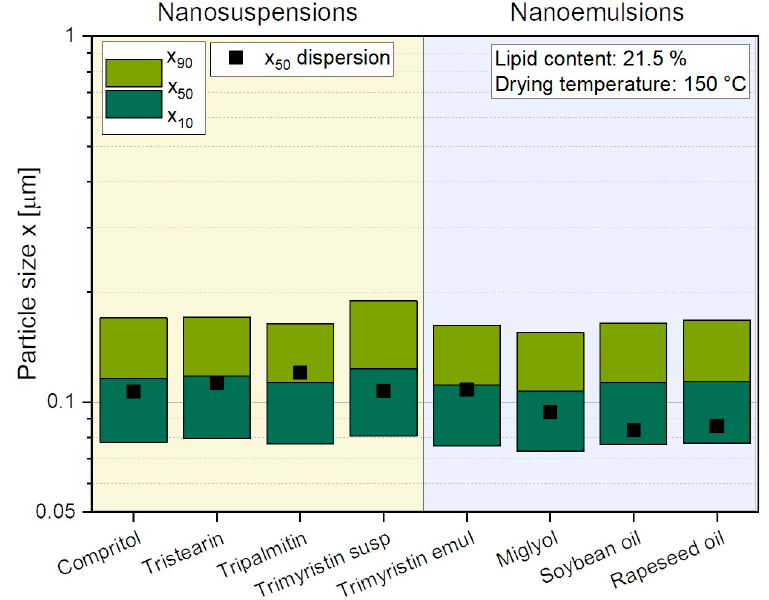
Figure 4. Particle size distributions after redispersion of spray-dried powders containing various lipid nanosuspensions and -emulsions. Trimyristin was embedded in the powders as suspension (susp) and emulsion (emul). The x 50 values of the original dispersions before spray drying are also given for comparison.